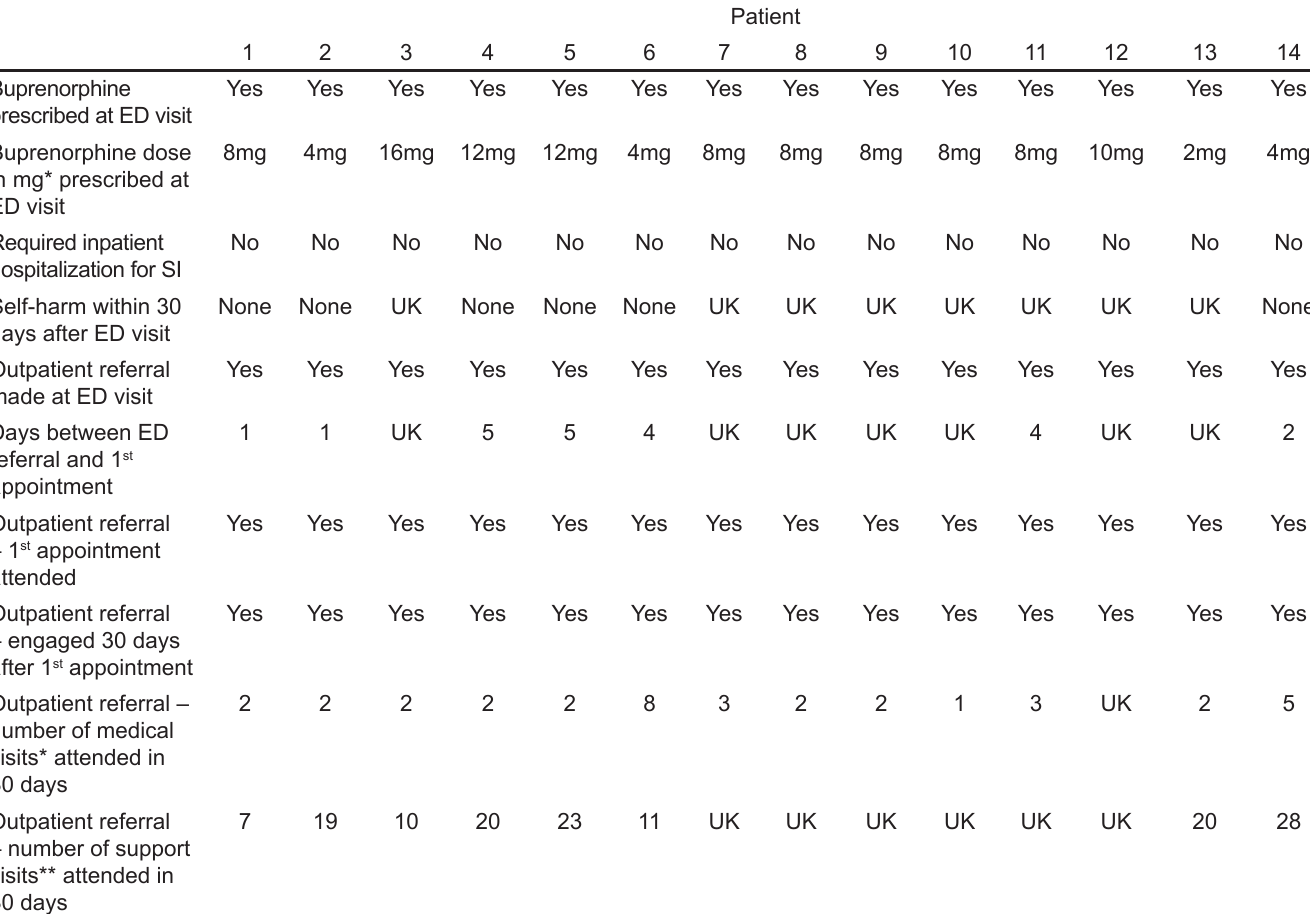
Table 2. Buprenorphine initiation and outpatient-treatment engagement for 14 patients with opioid use disorder and suicidal ideation at presentation to the emergency